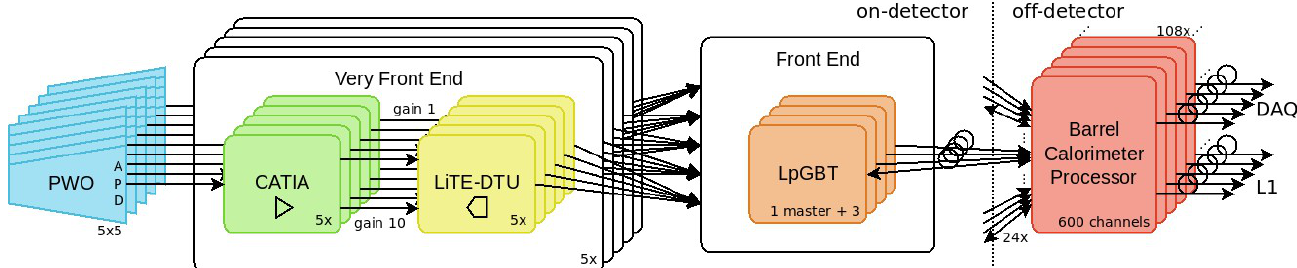
Figure 2. Schematic showing the layout for the CMS ECAL on- and off-detector readout for HL-LHC for a 5 × 5 crystal matrix.